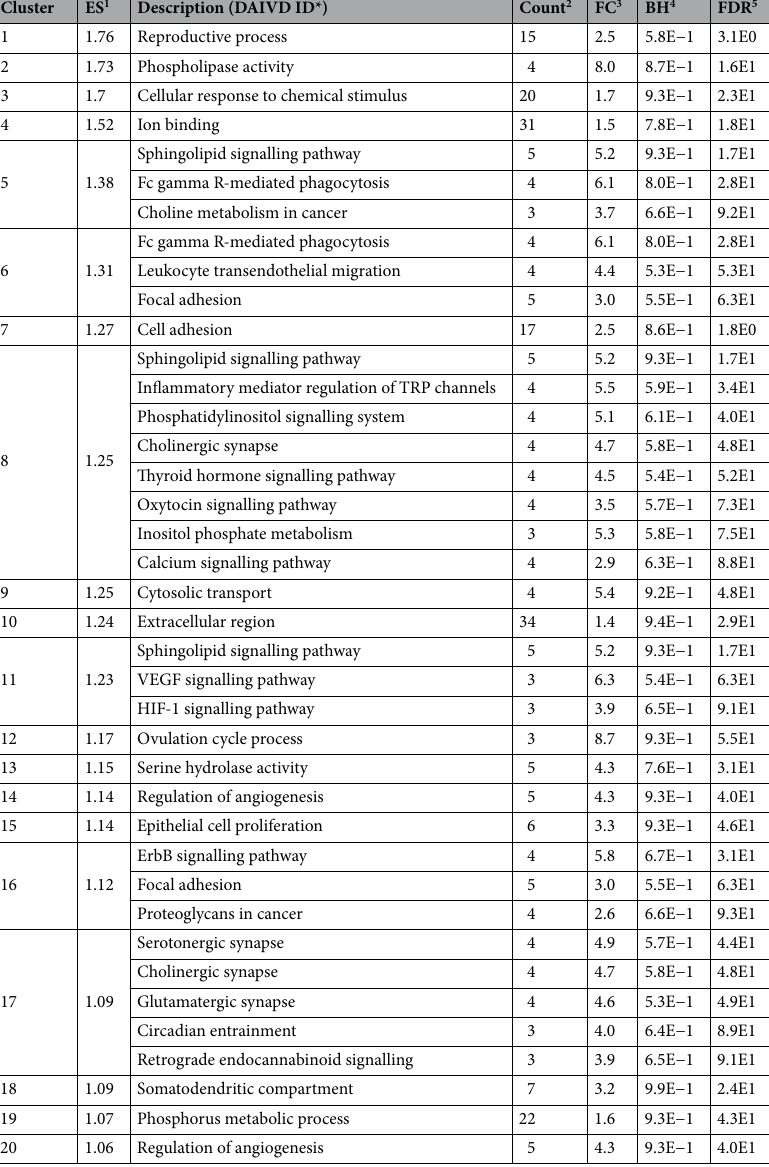
Table 2. Functional annotation clusters identified during the PF-SF transition in domestic cat using DAVID. The top 20 categories grouped by similar GO and KO terms are listed. The full list containing 27 identified clusters is found in Supplementary Data 2, “DAVID PF-SF”. *Internal gene ID defines unique gene cluster belonging to a gene entry. 1 Enrichment score, geometric mean of member’s P values of the corresponding annotation cluster in − log10 scale of the annotation cluster. 2 Number of gene counts. 3 Fold-change. 4 Benjamini-Hochberg value. 5 False discovery rate ( P value